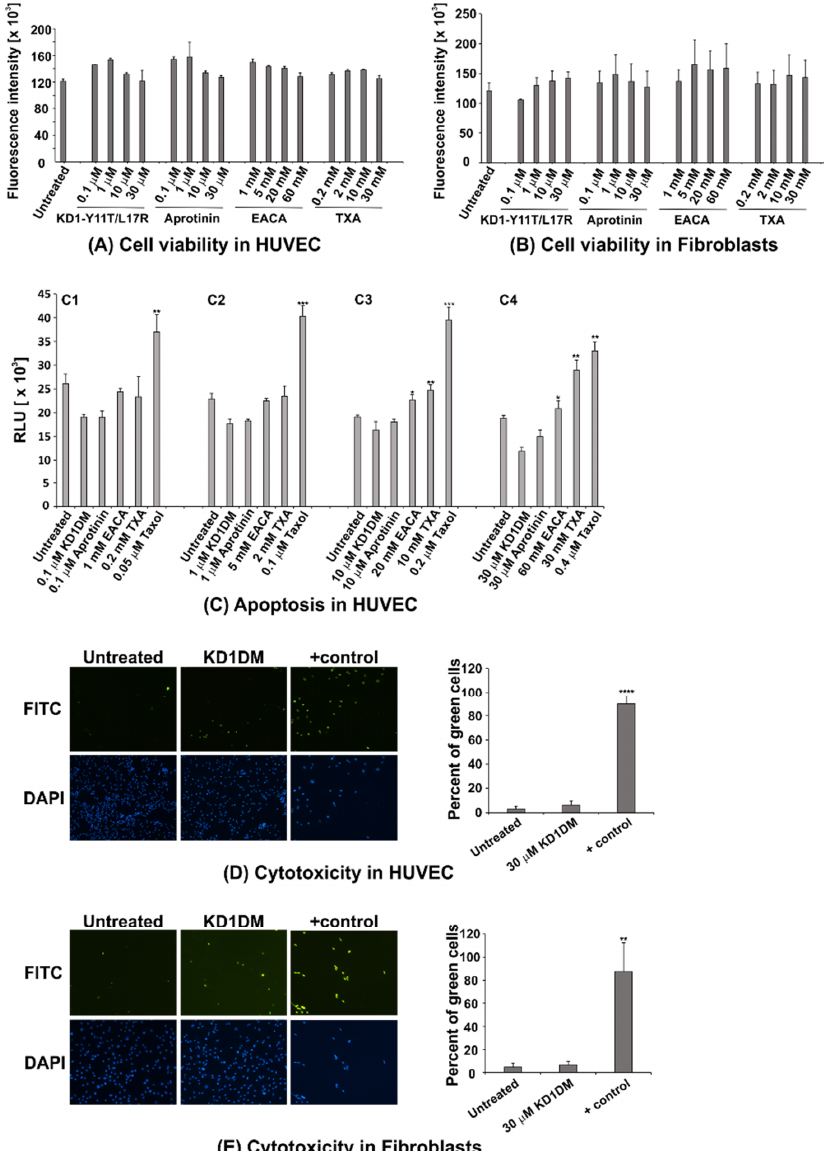
Figure 11. Toxicity studies of KD1-Y11T/L17R-K COOH , aprotinin, EACA and TXA in primary endothelial cells or fibroblasts. ( A ) Cell viability in HUVEC and ( B ) in primary human skin fibroblasts. Cells were treated with KD1-Y11T/L17R-K COOH , aprotinin, EACA, or TXA for 24 h at the indicated concentrations. Fluorescence intensity is plotted against concentration of each antifibrinolytic inhibitor. Note that, fluorescence intensity is proportional to relative cell number. Data points represent means from three independent experiments ± SEM. In each case, cell viability appears to be not significantly different from the untreated cells ( p > 0.05). ( C ) Apoptosis in HUVEC cells. HUVEC cells were either untreated or treated with KD1-Y11T / L17R-K COOH , aprotinin, EACA or TXA for 24 h at increasing concentrations ( C1 – C4 ). Taxol was included as a positive control. Luminescence, displayed as relative light units (RLU), is proportional to caspase-3 / 7 activity. EACA and TXA, but not KD1-Y11T / L17R-K COOH or aprotinin show significantly increased caspase activity at concentrations used in C3 and C4 compared to the untreated cells. Data are mean ± SD from three experiments. (* p < 0.05, ** p < 0.01, *** p < 0.001). ( D ) Absence of cytotoxicity in HUVEC and ( E ) primary human skin fibroblasts with KD1-Y11T / L17R-K COOH . Cells were either untreated or treated with 30 µ M KD1-Y11T / L17R-K